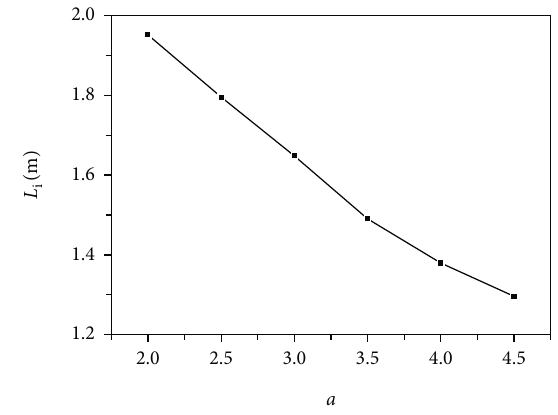
Figure 8: Relationships between L